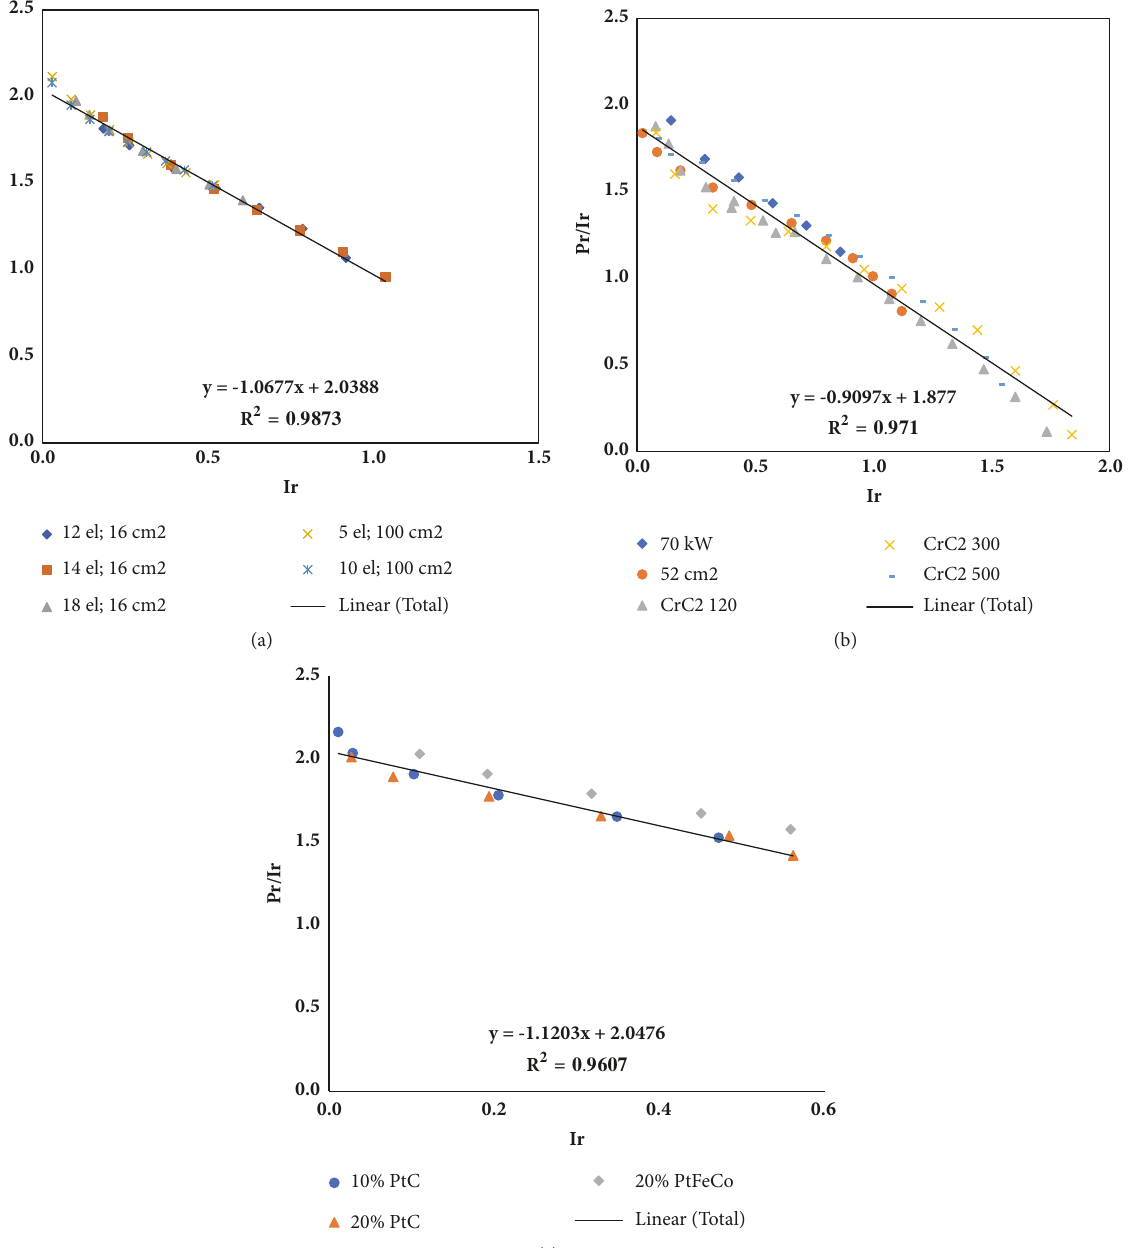
Figure 4: Graphical representation of the experimental data obtained after the application of the proposal equation for (a) fuel cells constructed in the laboratory, (b) PEM fuel cells taken from literature, and (c) phosphoric acid fuel cell taken from